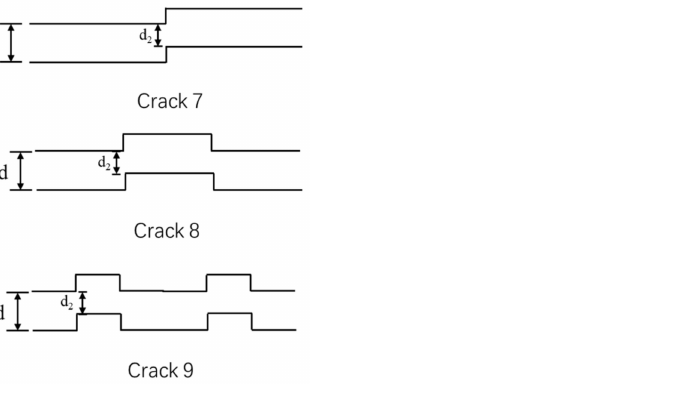
Figure 5. Geometries of tortuous cracks with narrow points adopted in the simulation.